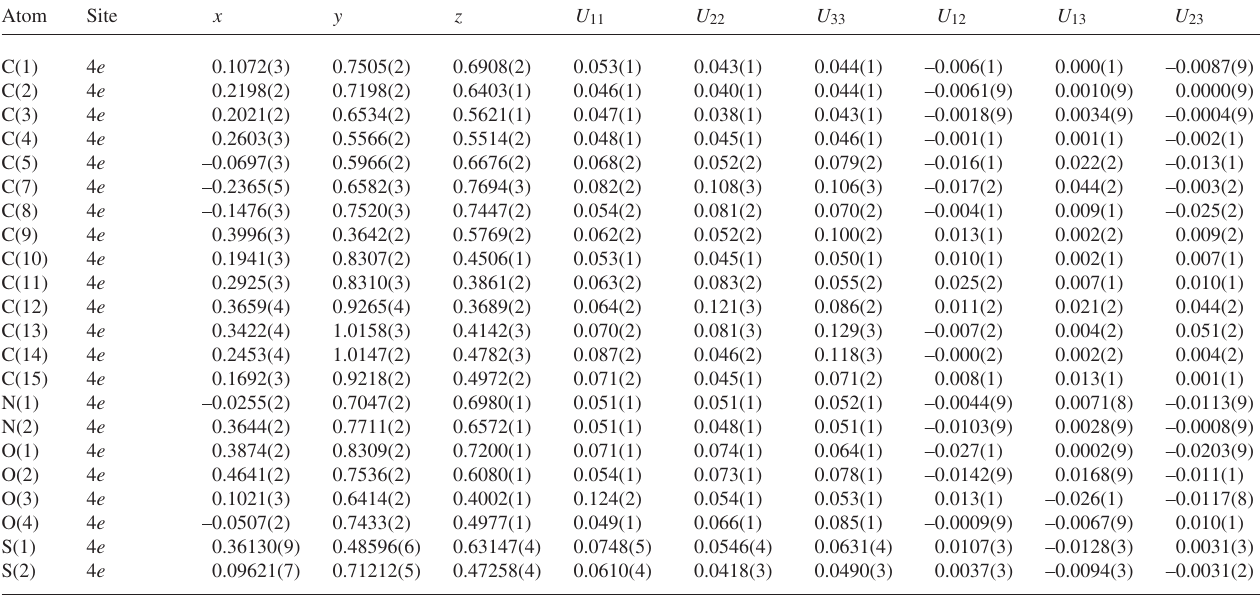
Table 3. Atomic coordinates and displacement parameters (in Å 2 ) .